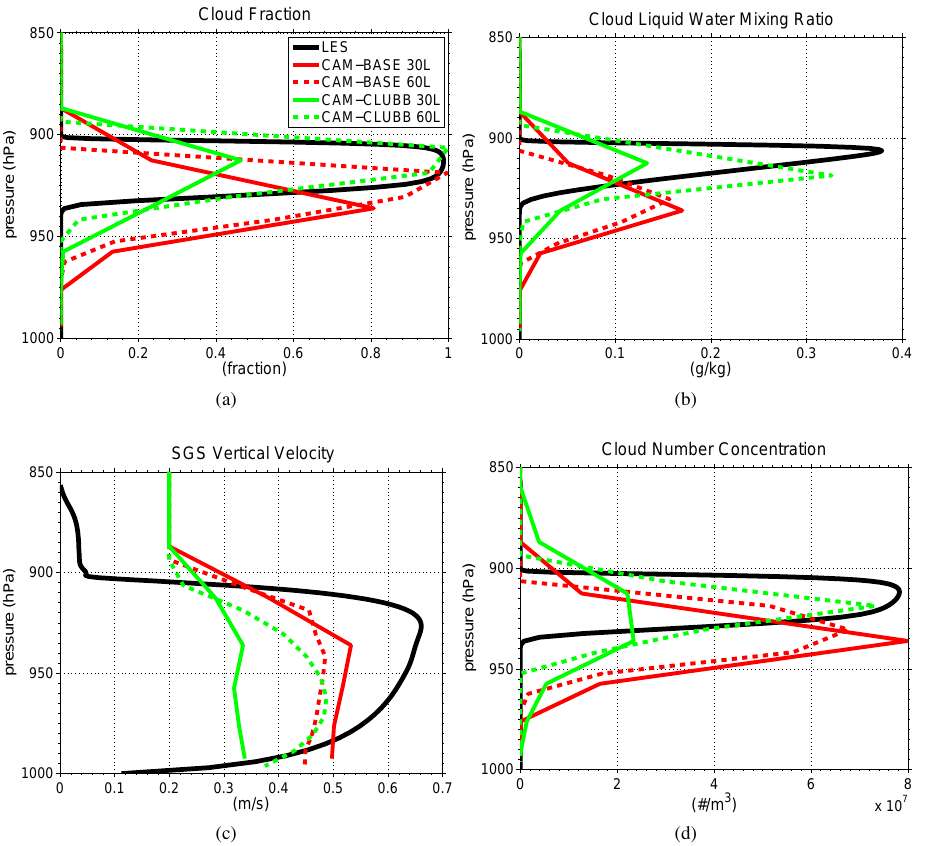
Fig. 9: Same as Fig. 2 except SCAM profiles represent DYCOMS2-RF01 simulations averaged over hours 4–6, with fixed 30 and 60 vertical levels and ∆ t =1800s .